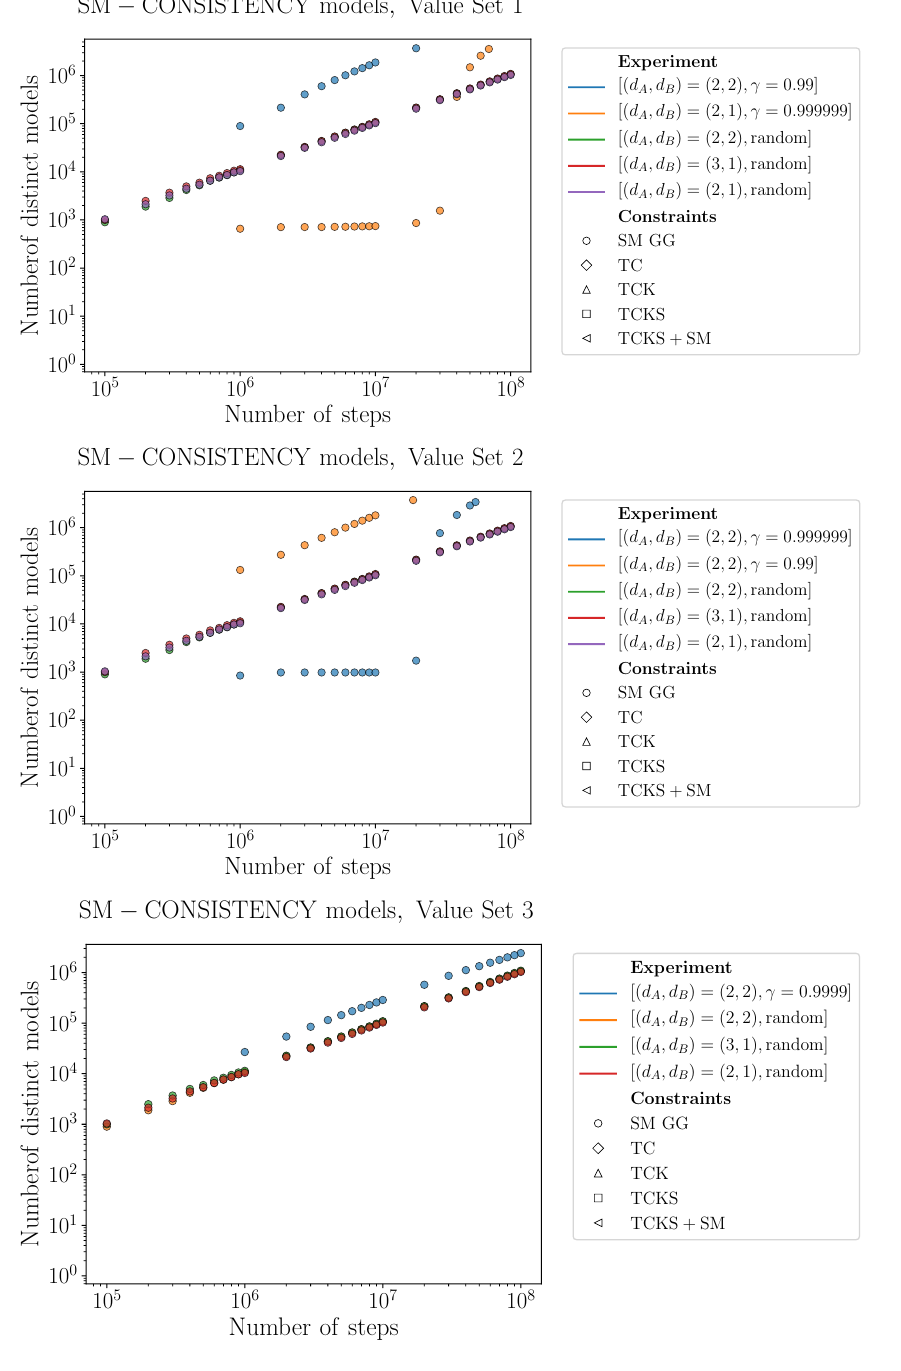
Figure 8 . Experimental results for reward function SM-CONSISTENCY. Results depend on choices of value sets as in table 4. Results for value sets 1, 2, and 3 are at top, middle, and bottom, respectively.